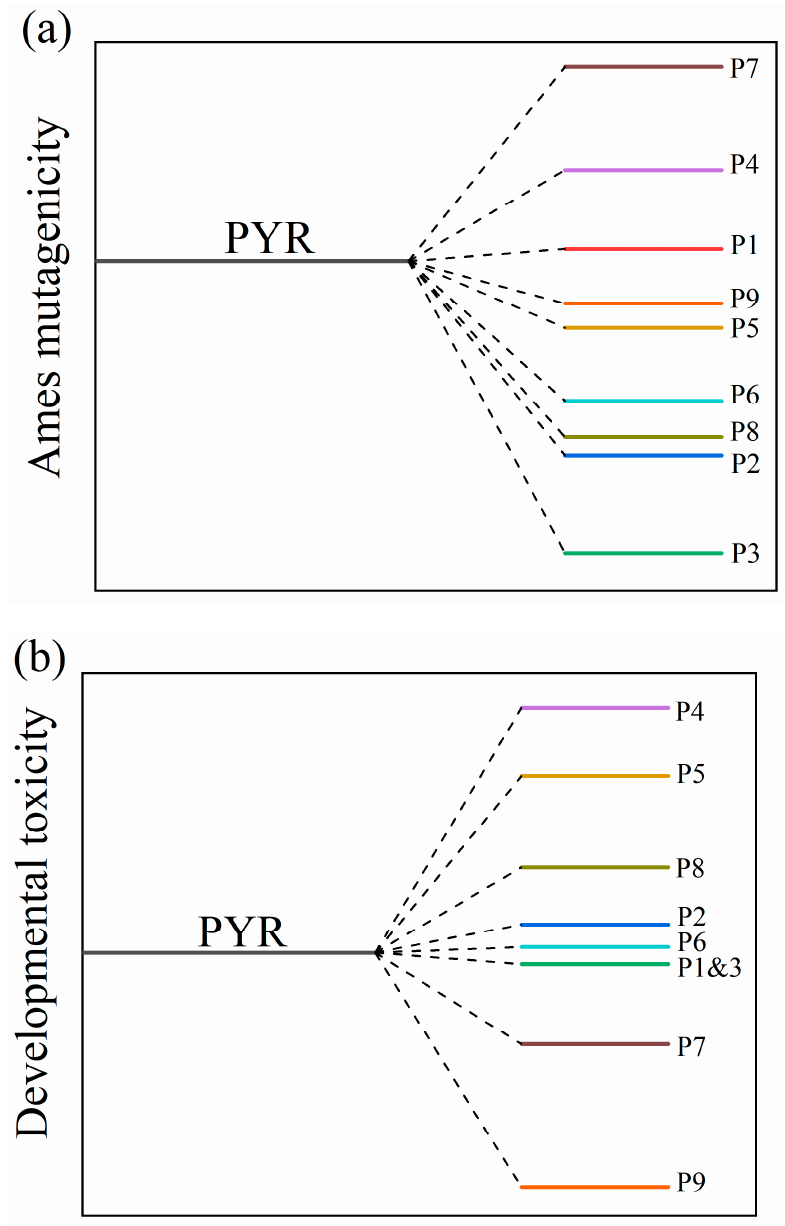
Figure 11. Ecotoxicity evaluation of PYR and intermediate products. ( a ) Ames mutagenicity, ( b ) Developmental